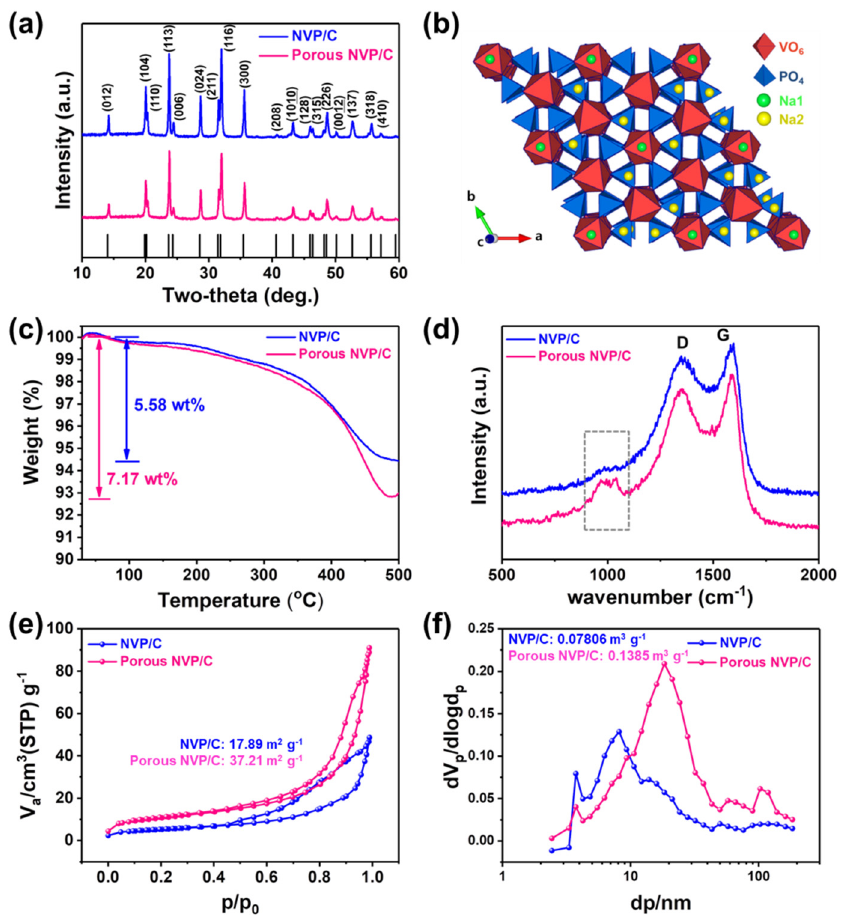
Figure 2. ( a ) XRD patterns of the NVP/C composites and the Porous NVP/C composites. ( b ) Crystal structure of NVP. ( c ) TGA results of the NVP/C and Porous NVP/C composites for analyzing the carbon contents in the composites. ( d ) Raman spectra of the NVP/C and Porous NVP/C composites. ( e ) N 2 adsorption–desorption isotherm. ( f ) Pore size distribution of the NVP/C and Porous NVP/C composites.